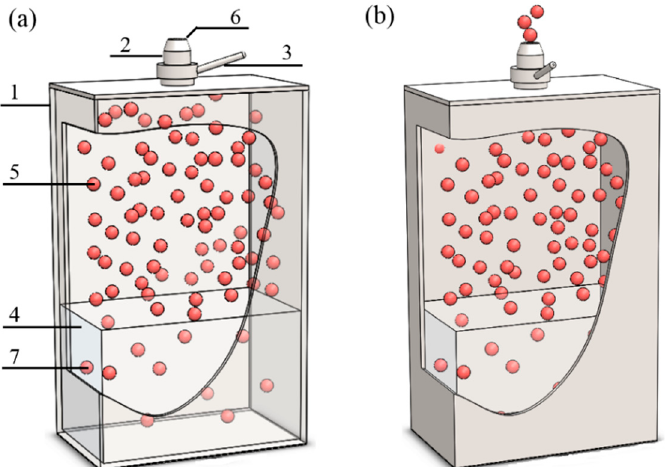
Figure 1. GLD battery model: ( a ) Schematic diagram of the gas–liquid dynamics (GLD) model; ( b ) discharge (deflation) process diagram of GLD model. 1—cylindrical closed container. 2—pipe. 3—valve. 4—liquid. 5—gas in the container. 6—pipe outer nozzle. 7—gas dissolved in liquid.